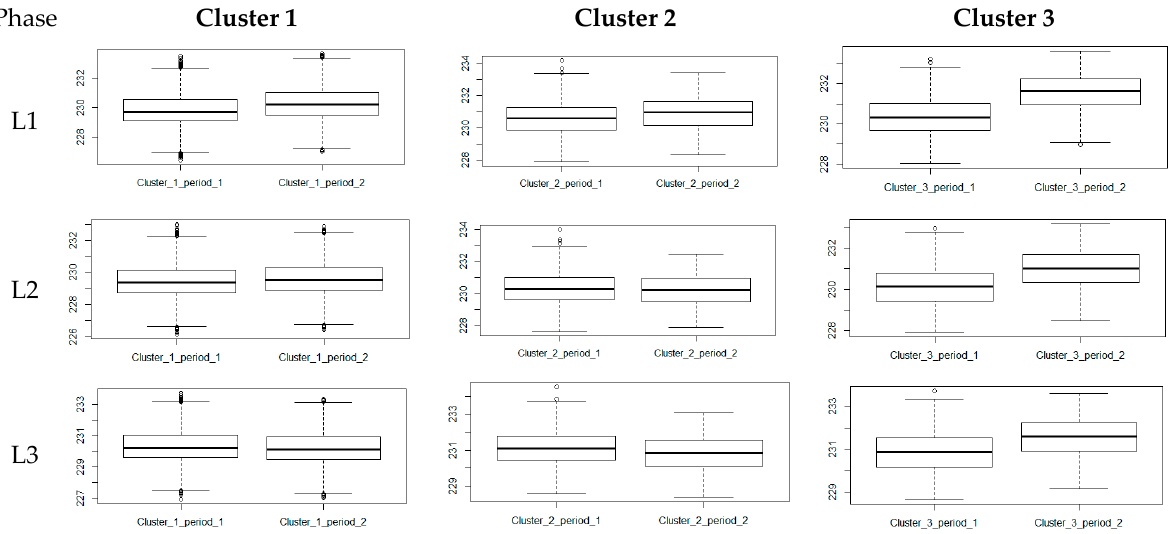
Figure 9. Box plots of voltage comparing periods for individual clusters in each phase. The Anderson–Darling test indicated a discrepancy from the normal distribution for Cluster 3 in phases L1 and L2 (black color, Table 8). For the remaining variants, the sets converged to the normal distribution. The distribution of the data is shown in Figure 8. Table 9. Wilcoxon rank-sum test of the shift parameter for voltage ( α = 0.05) in each phase. Phase